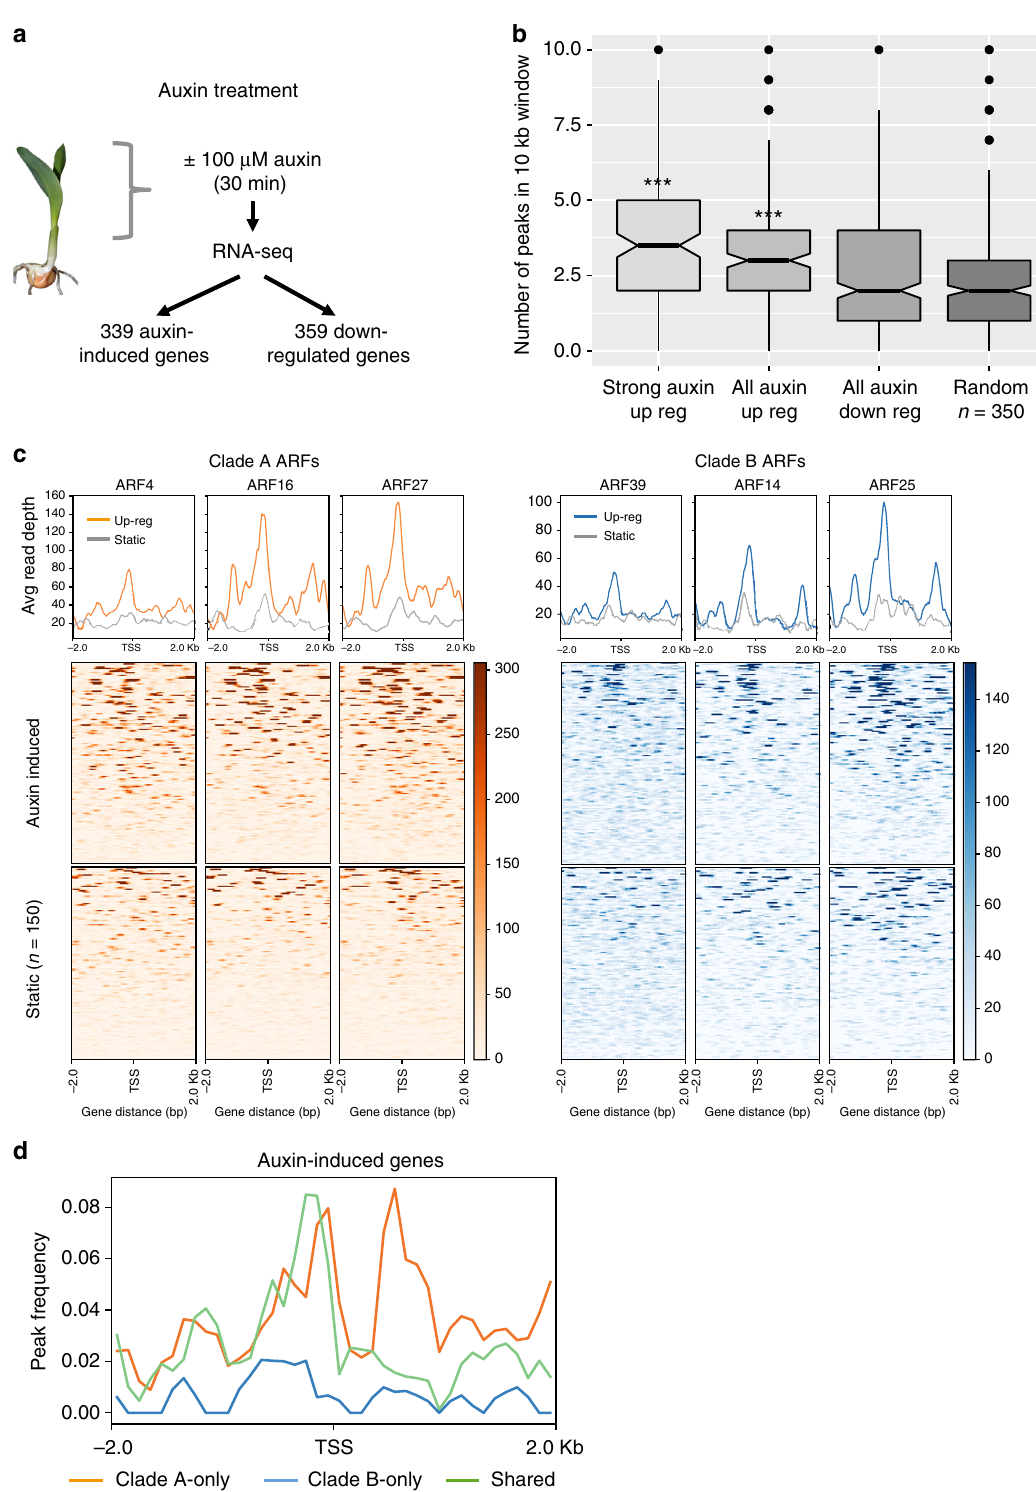
Fig. 4 Early auxin-induced genes contain ARF peaks proximal to the TSS. a Schematic of auxin induction experiment. b Auxin-induced genes have a small but signi fi cantly greater number of ARF peaks located within 10 kb relative to random genes. *** indicates p -value <3.8e − 7, pairwise t -test; central line shows median, upper, and lower hinges show fi rst and third quartiles, notches show 95% con fi dence intervals. c Representative examples of clade A and clade B ARFs showing increased binding in regions proximal to the TSS for auxin-induced genes relative to a similar number of randomly selected genes. d The increase in peak frequency near the TSS of auxin-induced genes can be attributed to sites bound by only clade A ARFs or bound by both clade A and clade B ARFs (shared